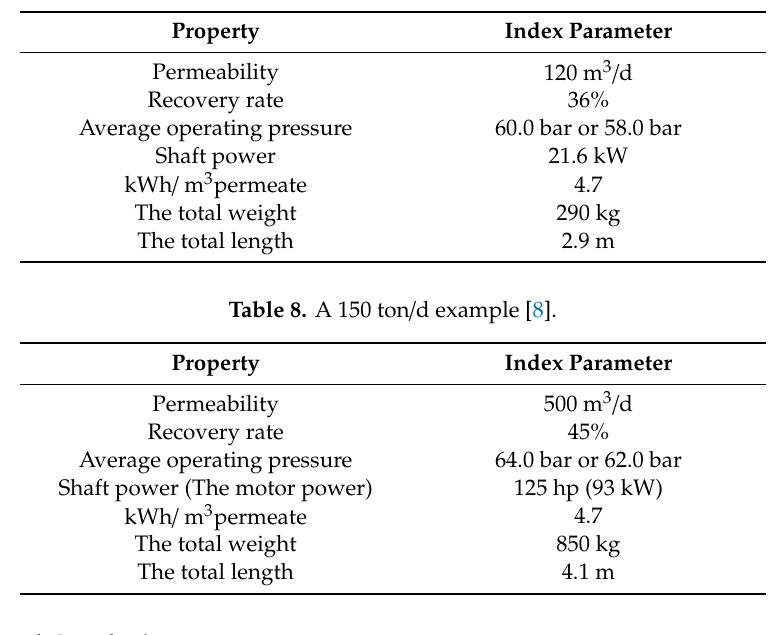
Table 7. A 120 ton / d example [8].